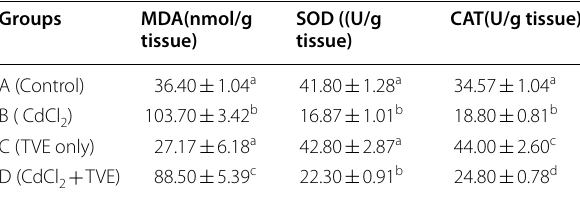
Values are Mean S.E.M, n 8; nmol/g, nanomoles per gram; U/g, units ± = per gram; TVE, Thymus vulgaris extract; CdCl 2 , Cadmium chloride; MDA, malondyaldehyde; CAT, catalase; SOD, superoxide dismutase. Mean values bearing different superscripts in the same column differ significantly at p